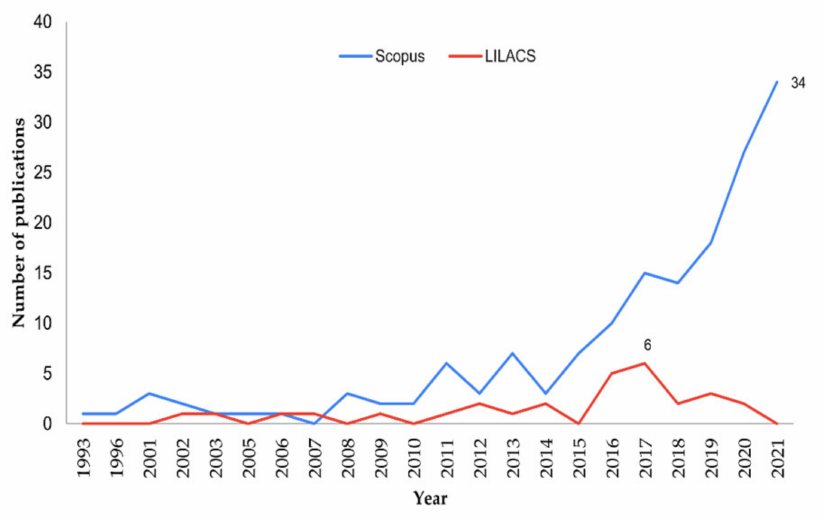
Figure 1. Timeline of publications in Scopus and LILACS.